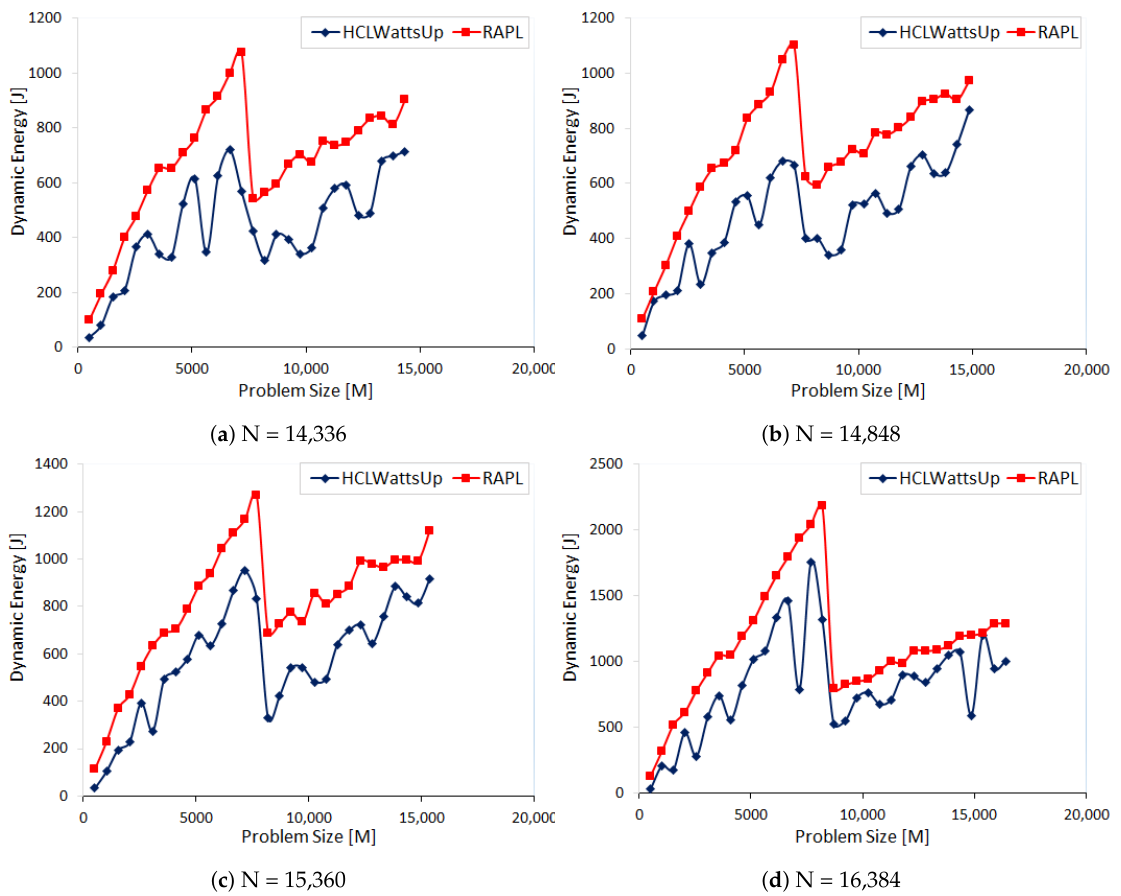
Figure 8. Dynamic energy consumption profiles of DGEMM on HCLServer01 and HCLServer02.